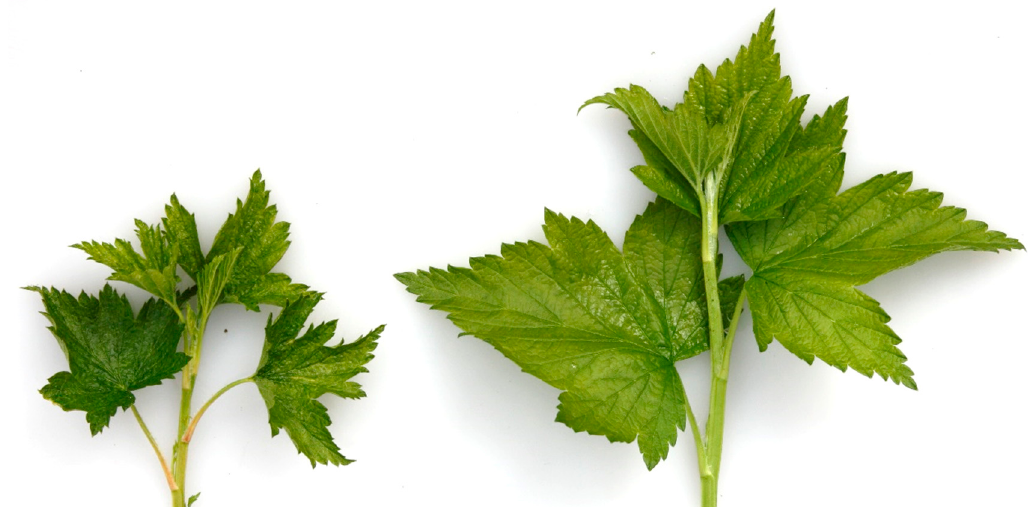
Figure 1. Symptoms observed on American blackcurrant infected with Ribes americanum virus A. Infected Ribes americanum cultivar Gall (PI 617879, left ) showing ragged leaf margins and crinkled leaf surface compared to healthy plant ( right ).